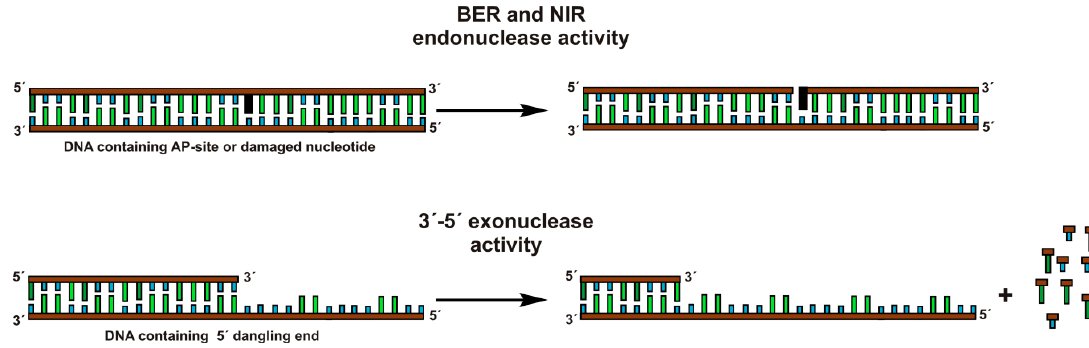
Figure 1. Types of catalytic activity for APE1.